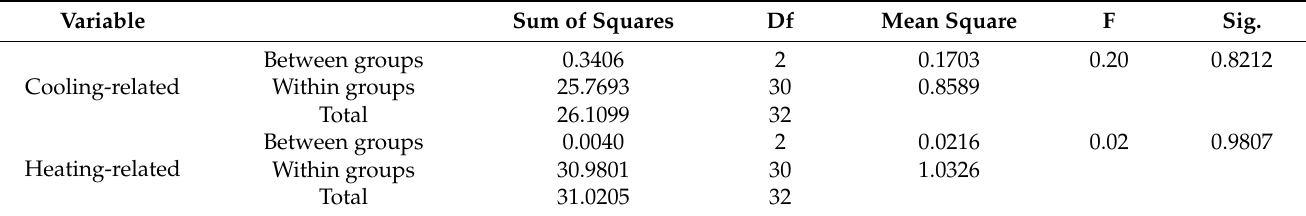
Table 4. ANOVA summary table for three approaches (SED, CPR, and MEA).